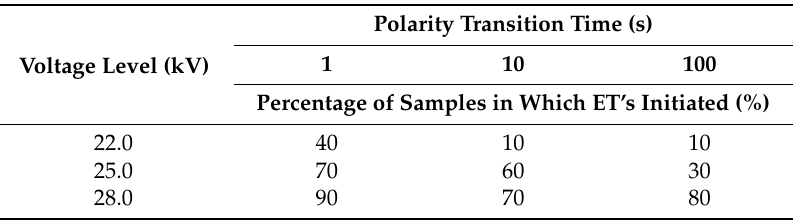
Table 3. Tree initiations at polarity reversing voltages.